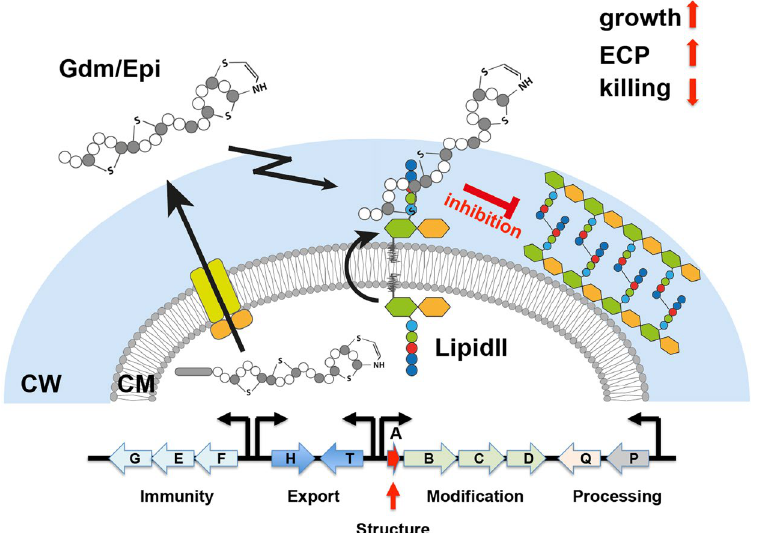
Figure 7. Overview on Gdm and Epis mode of action on the producers. Gallidermin/Epidermin are expressed in an inactive pro-form and secreted by the ABC-tranporter GdmHT/EpiHT, the secreted pro-form is processed by specific protease GdmP/EpiP to active Gdm/Epi. Despite the immunity system Gdm/Epi can inhibit the growth of the producer strain causing enhanced excretion of cytoplasmic proteins and the release of ATP and